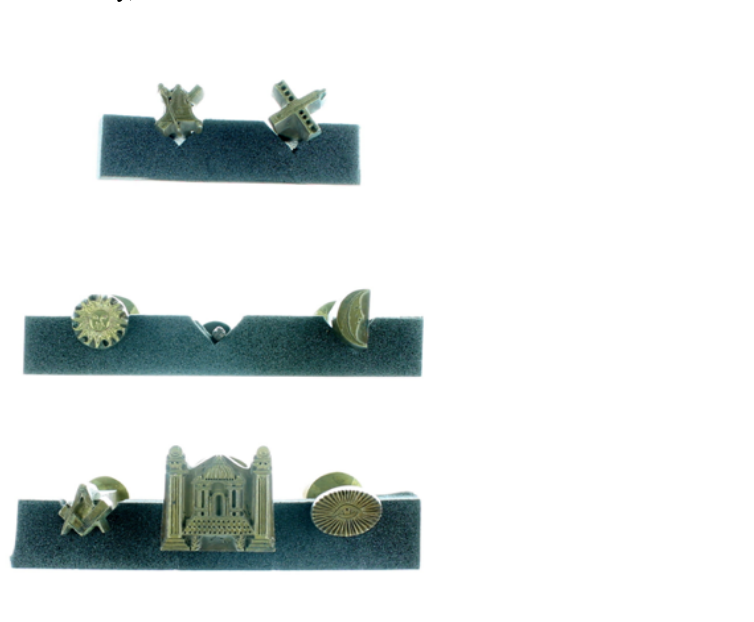
Fig. 13 . Finishing tools. Copyright and reproduced by permission of the Museum of Freemasonry,